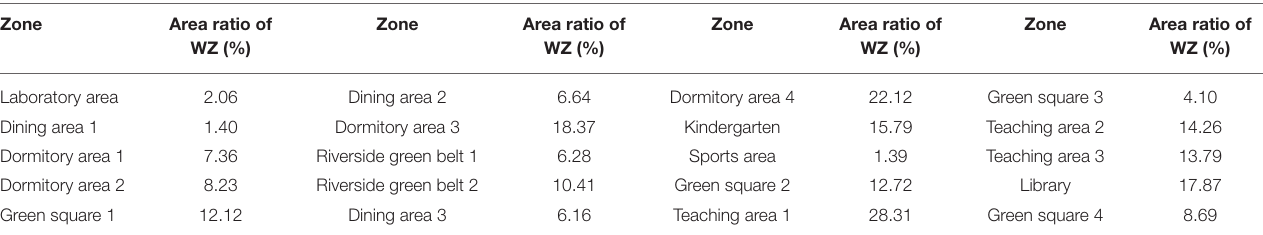
TABLE 5 | Area ratio of Windless Zone (WZ) in each